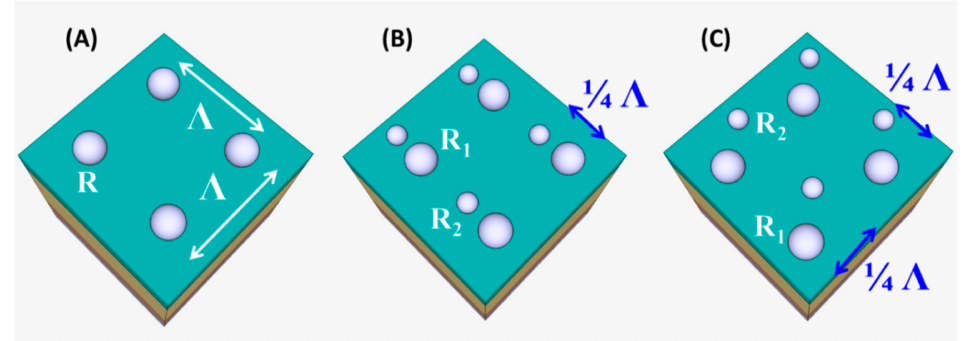
Figure 5. Schematic of the random Al nanoparticle array on top of GaAs solar cell ( A ) Uniform single nanoparticle array (15 different spatial arrangements with various combination of Λ = 200 nm, 300 nm, and 400 nm and R = 20 nm, 30 nm, 40 nm, 50 nm, and 60 nm. ( B , C ) Random double nanoparticle arrays (18 different spatial arrangements with various permutation of Λ = 200 nm, 300 nm, and 400 nm, R 1 = 55 nm, 50 nm, 45 nm, and R 2 = 25 nm, 35 nm, 40